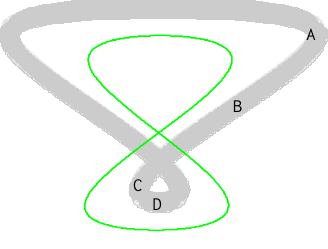
Figure 2. Coverage of GEO SAR satellite